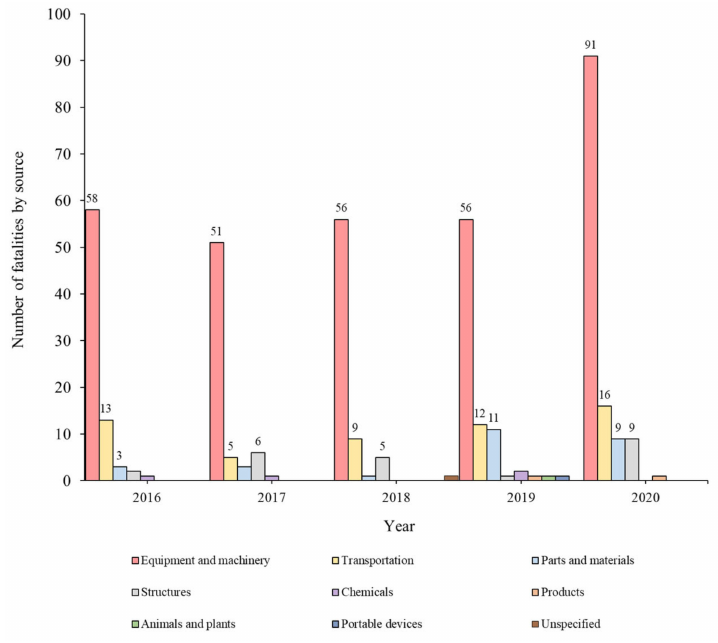
Figure 7. Sources of accidents caused by multiple processes in the